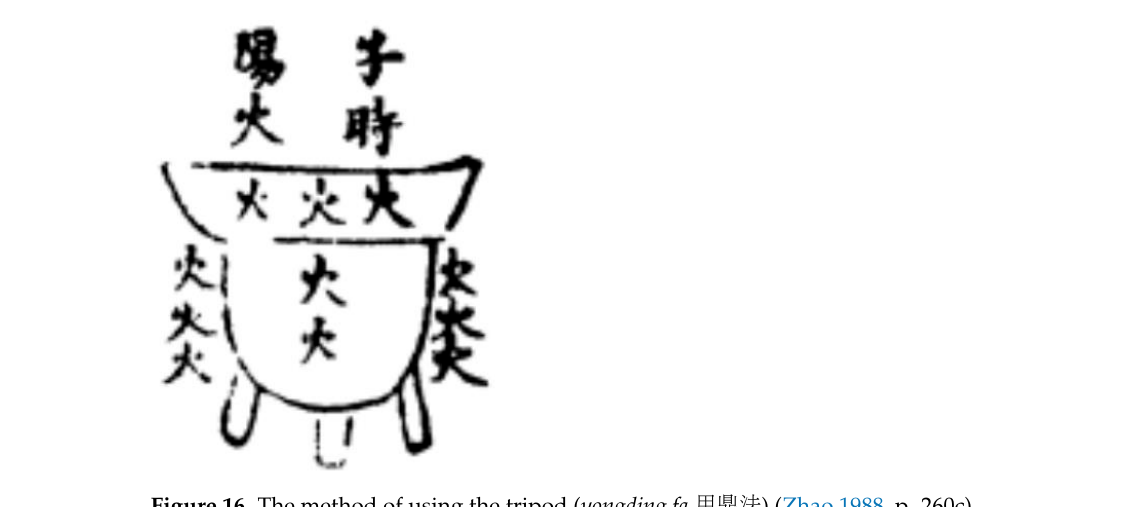
Figure 15. The cabinet of the fountain and the iron rack with three legs (Zhao 1988, p. 249c).